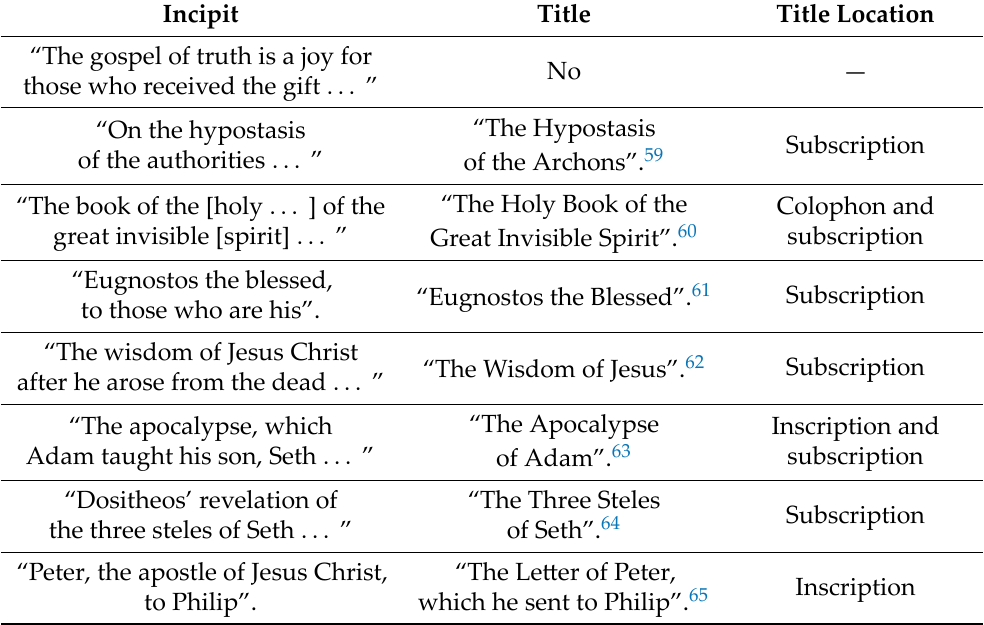
Table 4. Titles in Incipit from All Nag Hammadi